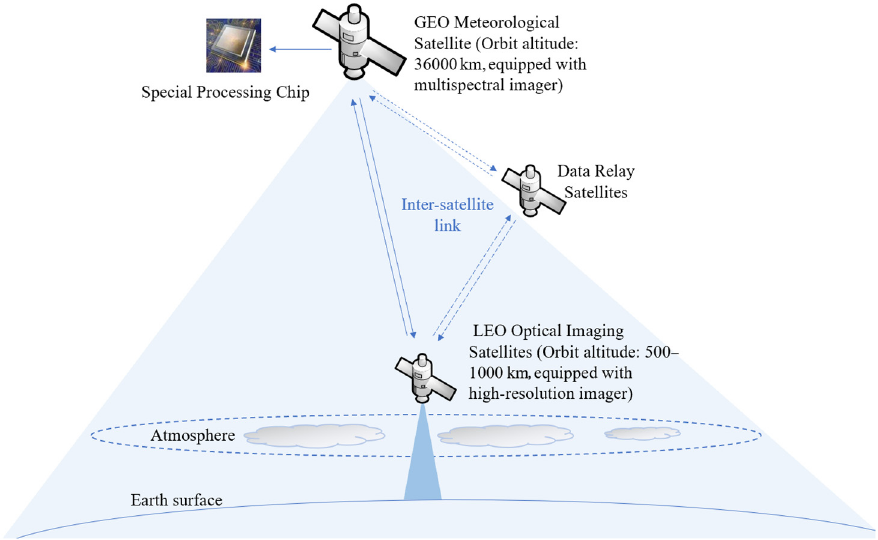
Figure 3. Framework of GEO–LEO satellites cooperation scheme.